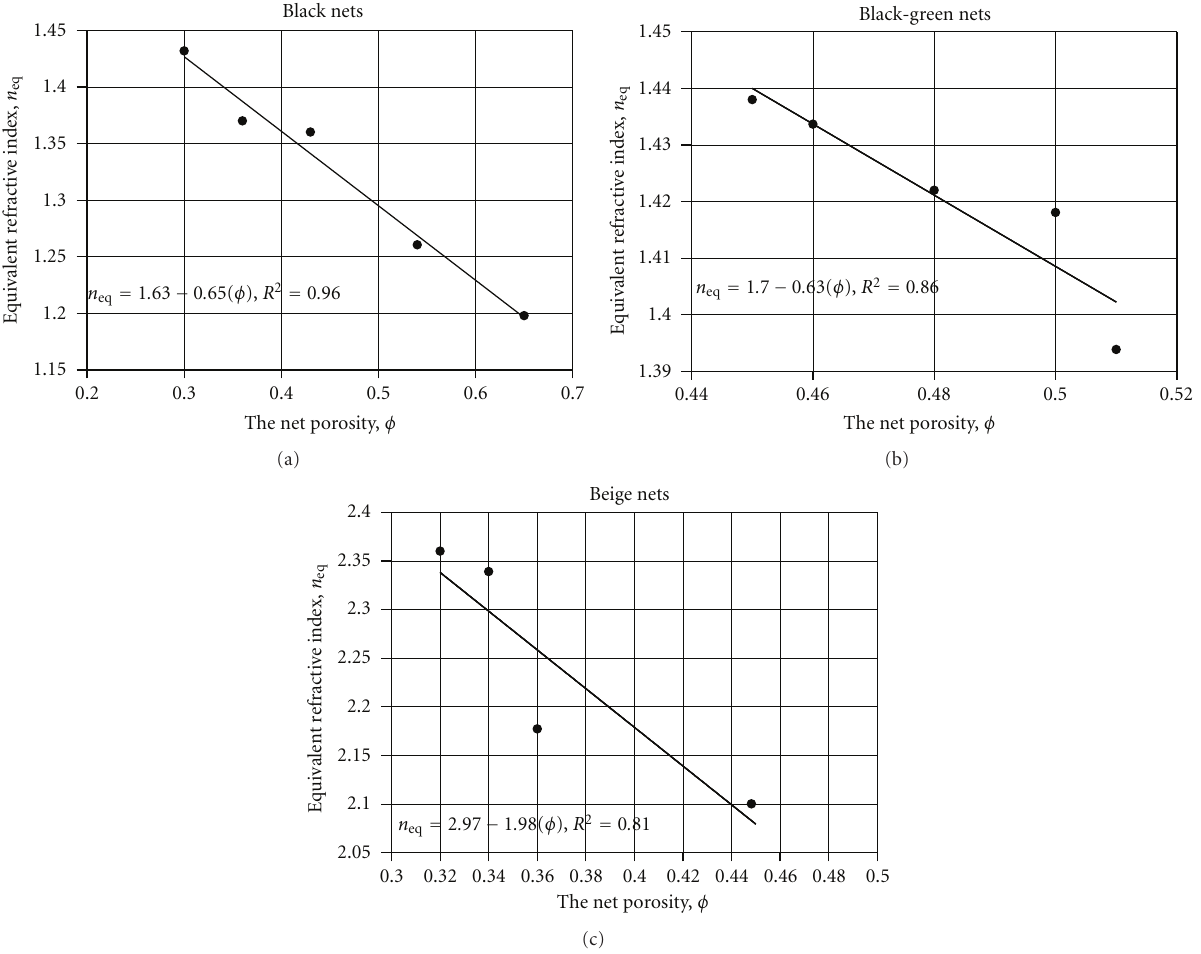
Figure 3: The equivalent refractive index ( n eq ) as a ff ected by the porosity of the tested nets: (a) is for the black group, (b) for the black-green group, and (c) for the beige